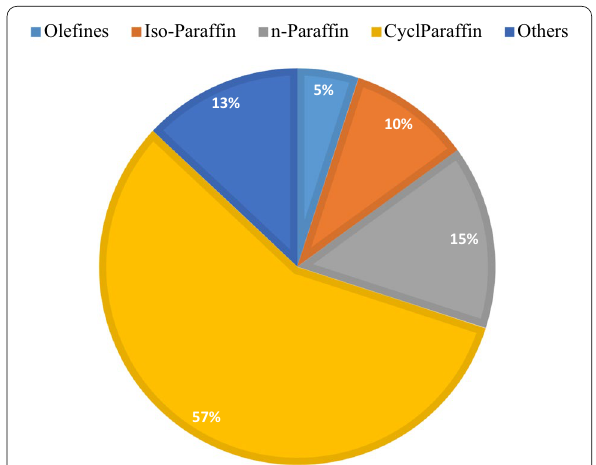
Fig. 6 GC Mass % of different hydrocarbons in carbon length C 8 –C 16 of WCO bio aviation fuel